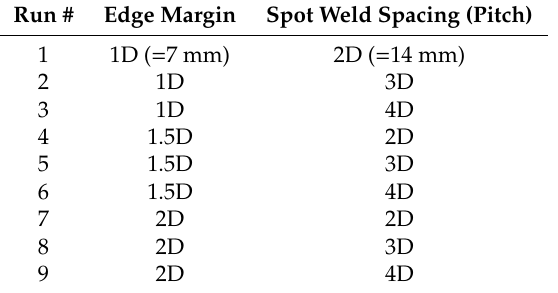
Table 2. DoE runs for making 9-spot-welded panels. D ( = 7 mm) is the spot weld diameter. Run # Edge Margin Spot Weld Spacing (Pitch)